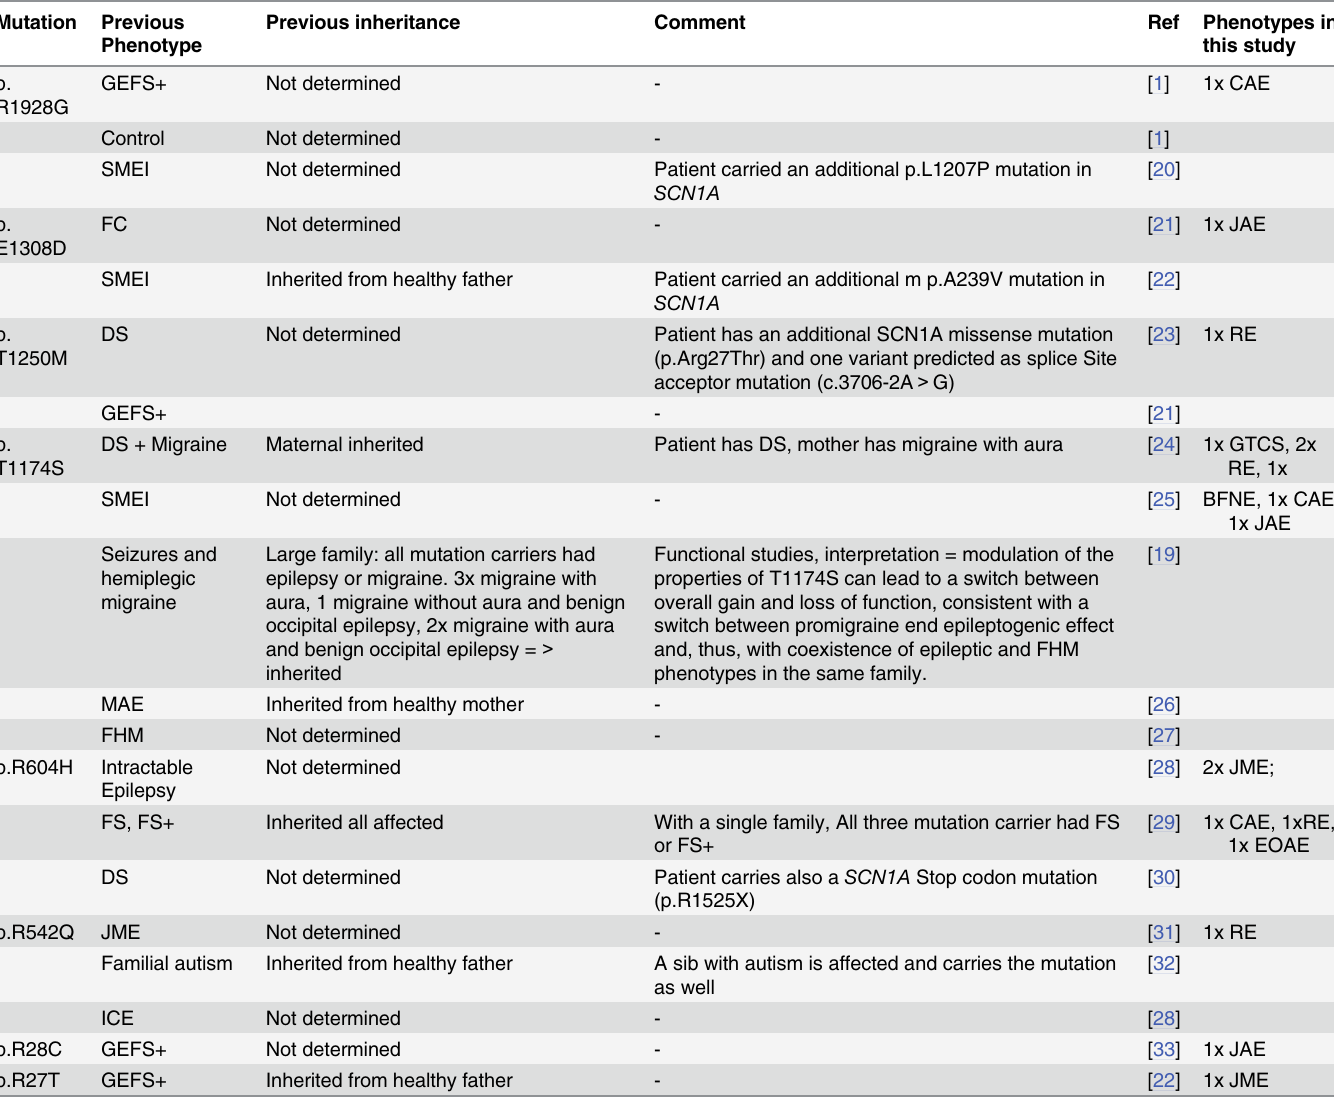
Table 2. Summary of previous studies referenced at the HGMD specific for each identified